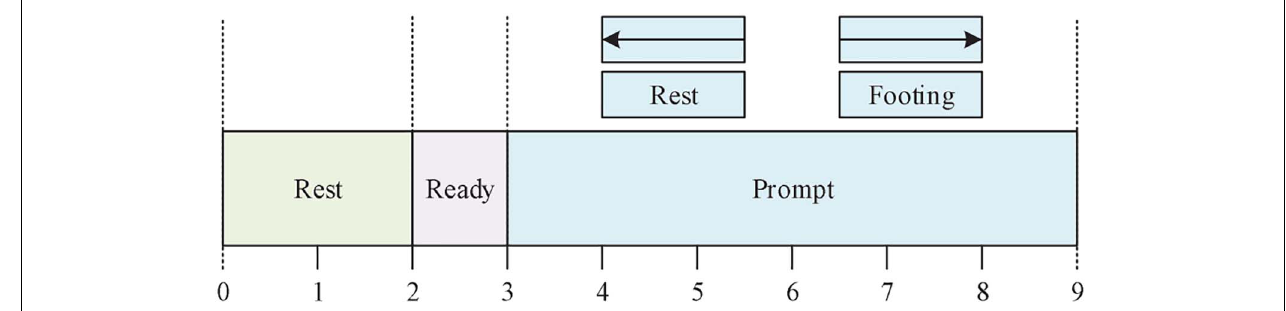
FIGURE 2 | MI experimental